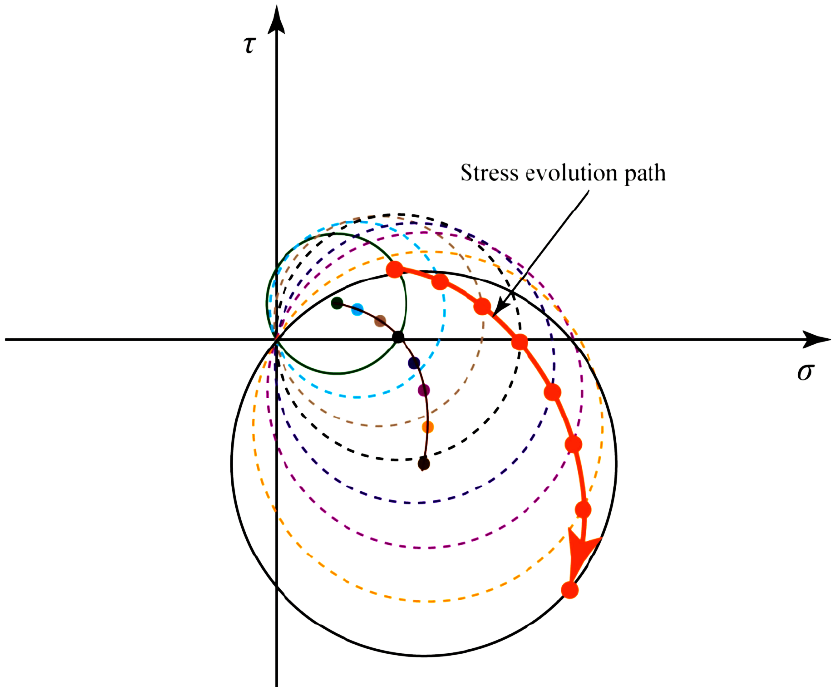
Figure 7. Stress path controlled by the in-situ stress ratio.